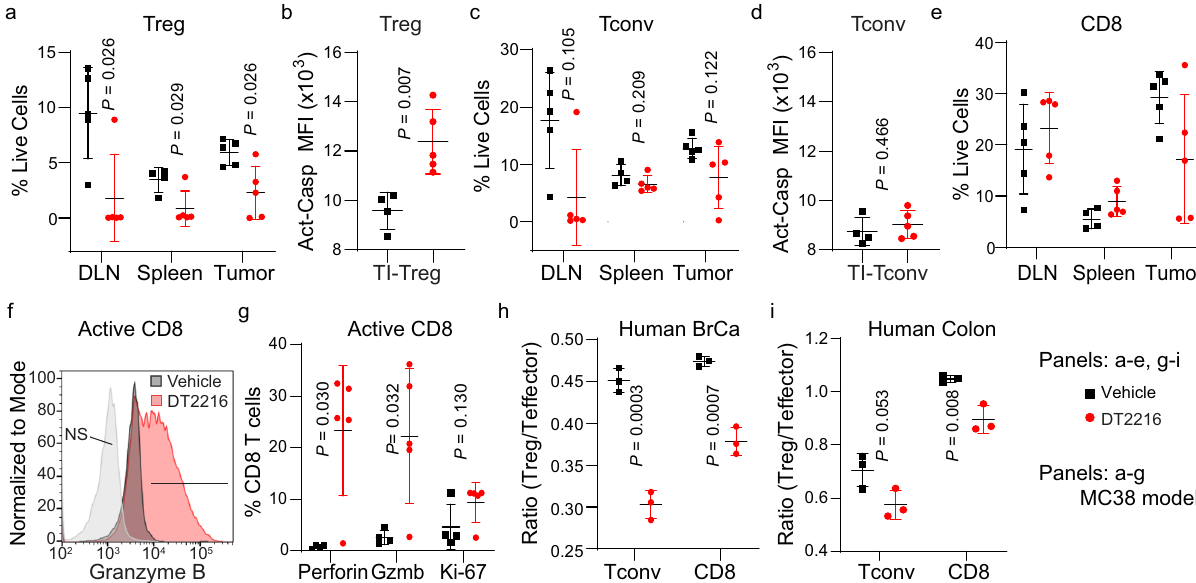
Fig. 4 Depleting the tumor microenvironment of BCL-X L leads to an apoptosis-induced decrease in the number of TI-Tregs. a Percentage of Tregs following treatment with the BCL-X L targeting PROTAC DT2216 (or vehicle) in the draining lymph nodes (DLN), spleens, and tumors from MC38 tumor- bearing mice. b Amount of pan-caspase labeling in TI-Tregs from MC38 tumor-bearing mice following treatment with DT2216 (or vehicle) as assessed by fl ow cytometry. MFI of pan-caspase activation probe is shown. c – e Percentages of Tconv ( c ) and CD8 + T ( e ) cells following treatment with DT2216,